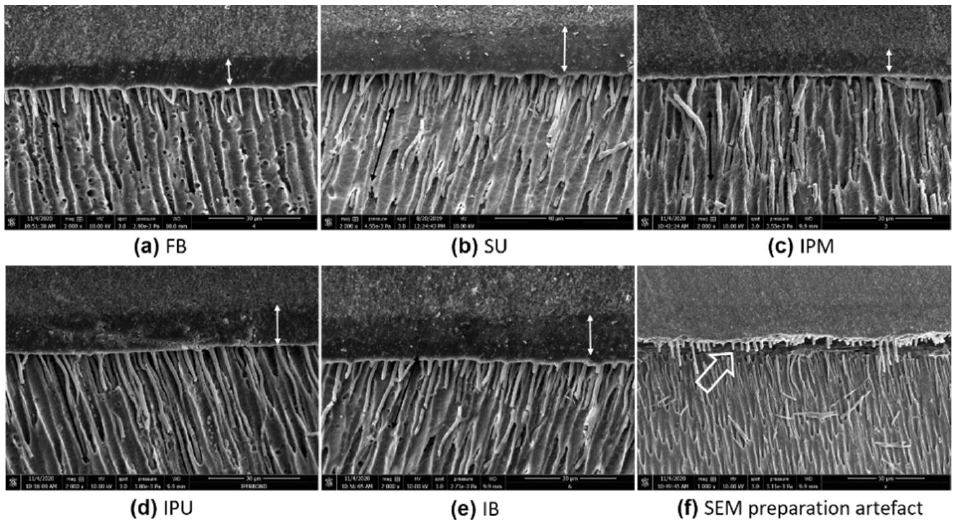
Figure 3. Representative photos of scanning electron microscopy (A-E, x2000 magnification) demonstrating the adhesive layer thickness (white arrows) and tag depth (black arrows). ( a ) FuturaBond